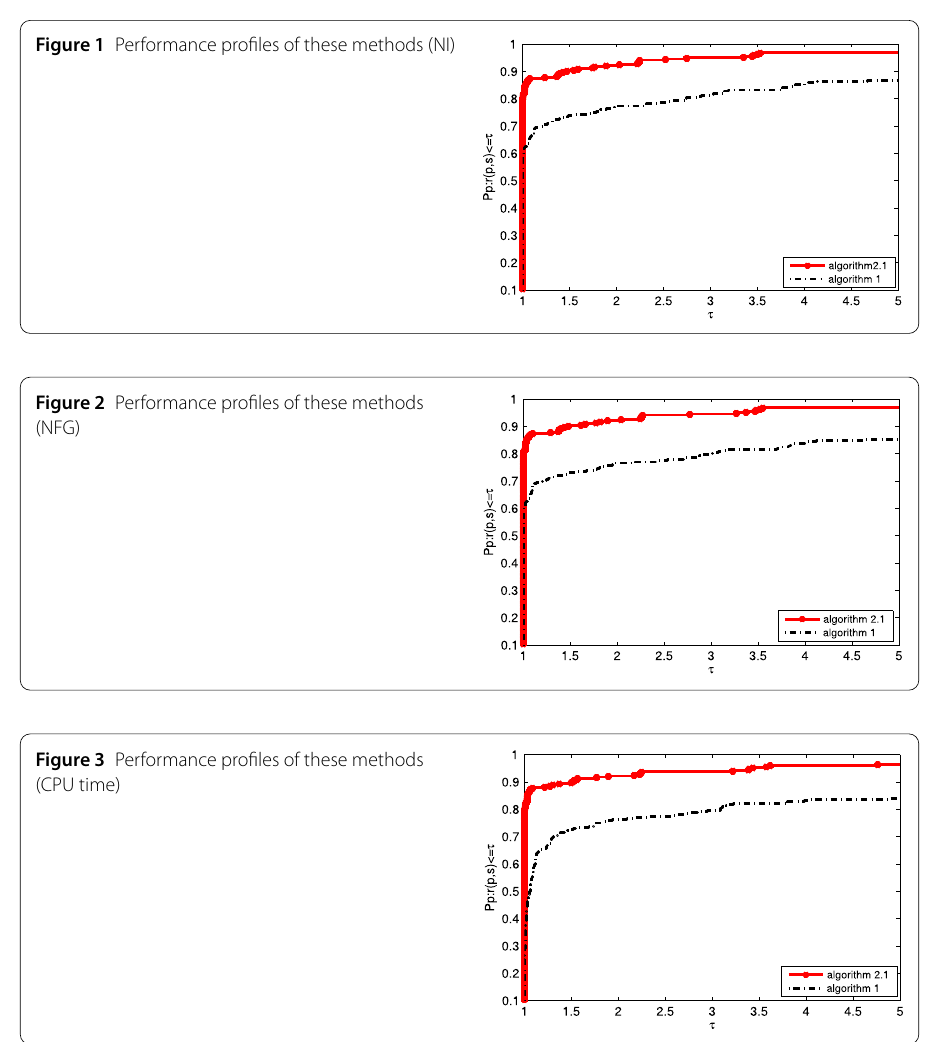
Figure 1 Performance profiles of these methods (NI)